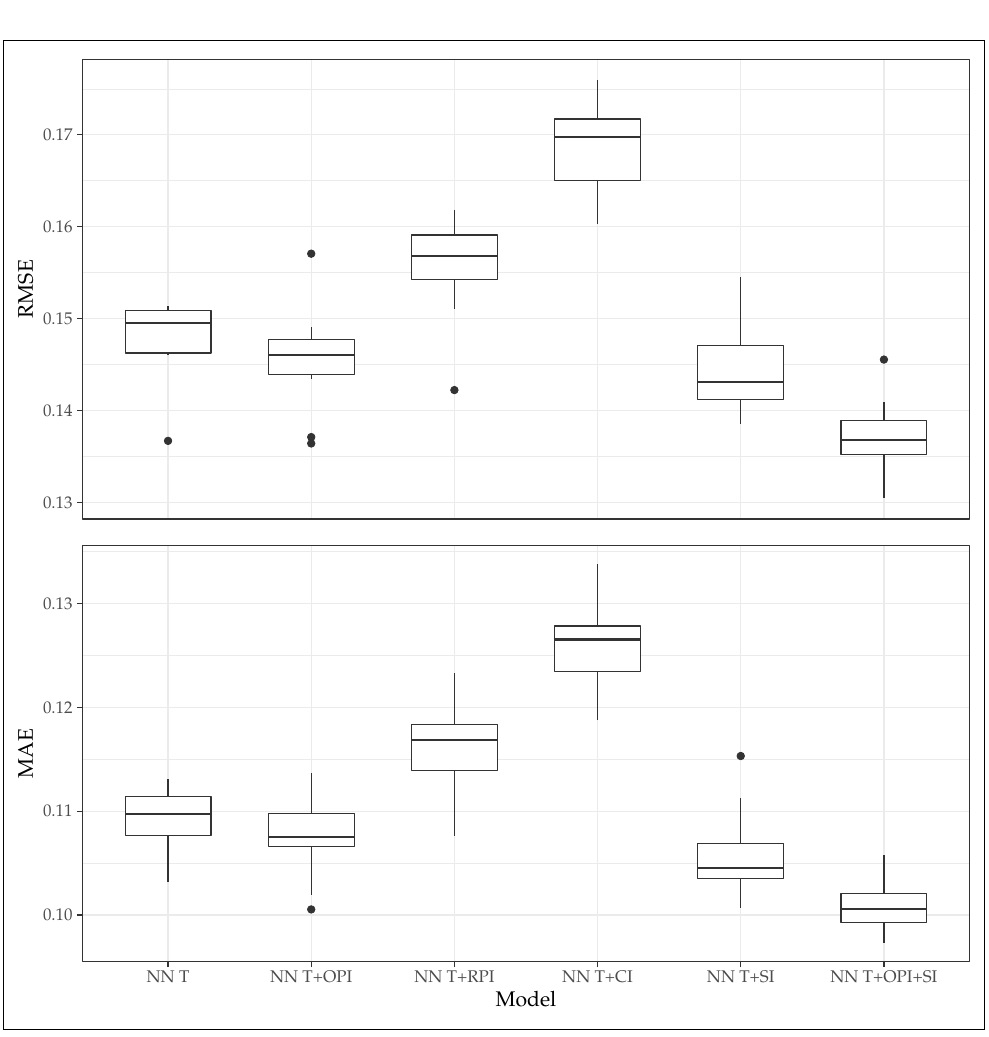
Figure 10. Distribution of 10-fold cross-validated results. Table 5. Single test set performances of NNs and ML